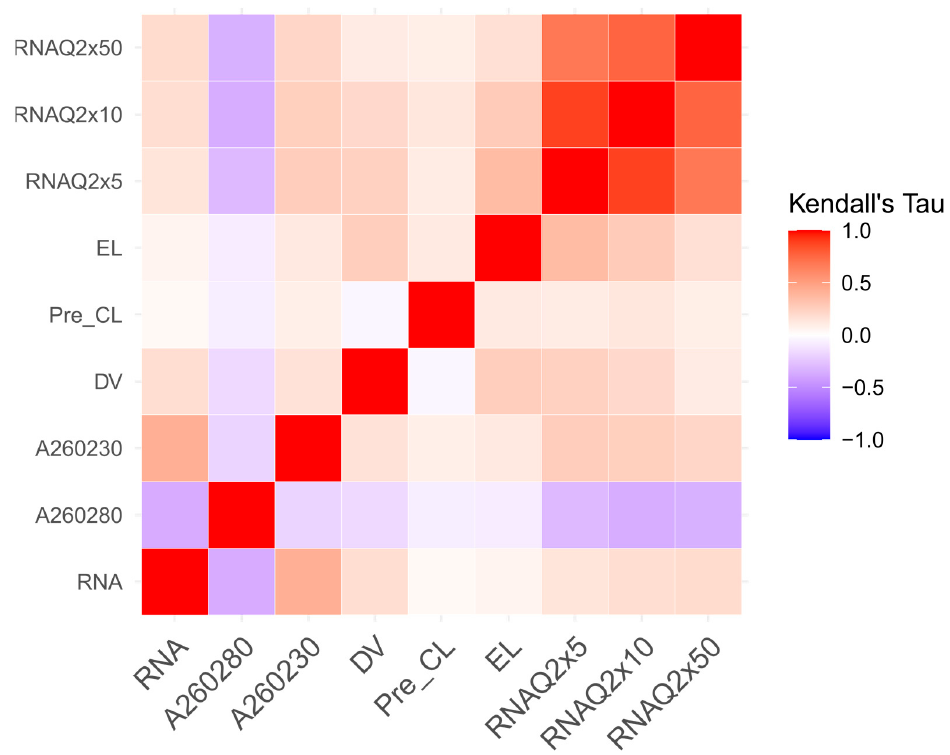
Figure 6. Kendall’s tau correlation coefficients between the RNA wet and sequencing coverage metrics. Table 4. Correlation analysis between the median coverage and wet metrics for the RNA samples. Correlations were evaluated through a tau test, evaluating the Kendal’s rank correlation coefficient (tau) significance between the wet metrics and coverage at three different depths (5X, 10X and 50X). Each cell reports: Kendall’s tau coefficient, p -value and tau 95% confidence interval. Significant correlations ( p -value < 0.05) are highlighted in bold.